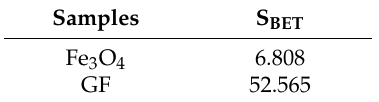
Table 5. Values of S BET .